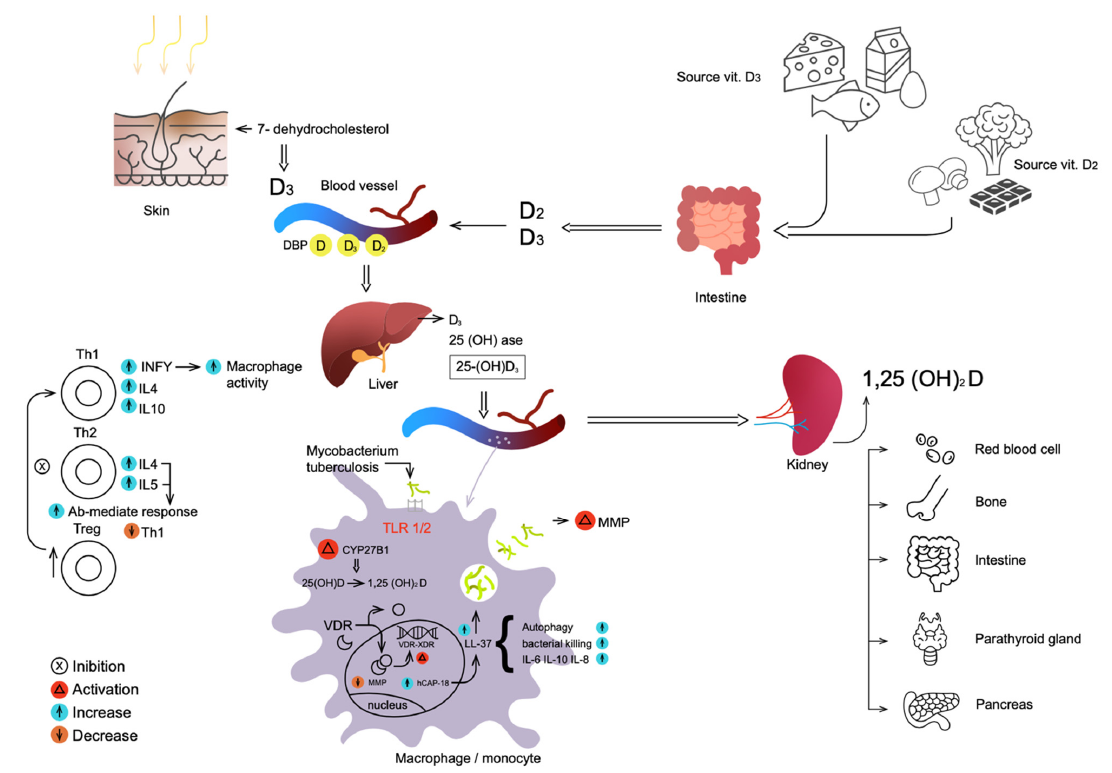
Figure 1. Metabolism and action of Vitamin D in MT infection. Vitamin D is synthesized in the skin following stimulation by UV rays or introduced with food. In the blood, vitamin D circulates free or bound to VDBP, reaches the liver, where it is converted to 25-(OH)-vit. D by the enzyme hydroxylase. Reintroduced into the bloodstream, it reaches the kidney, where it is further hydroxylated; this active form has multiple activities on different organs (parathyroid, bones, pancreas, intestine). Part of the 25-(OH)-vit. D enters the macrophages, where by hydroxylation it is activated, binds the VDR, passes into the nucleus and increases the transcription of genes for hCAP18. This, cleaved, produces LL-37, which has anti-MT activity, increases autophagy and macrophage killing. In addition, 25(OH)D modulates the innate and adaptive immune system and increases in cytokines (IL-4, IL-5), and INF- γ increases in the antibody-mediated response.